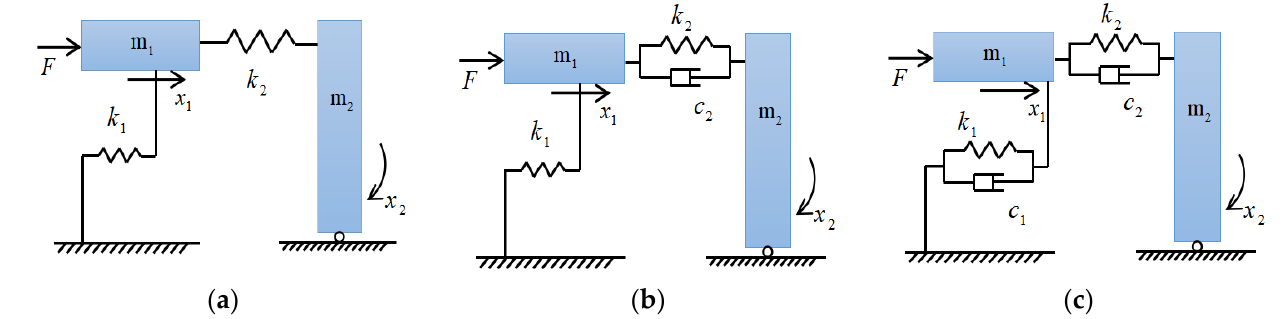
Figure 1. Schematic model of TMD.